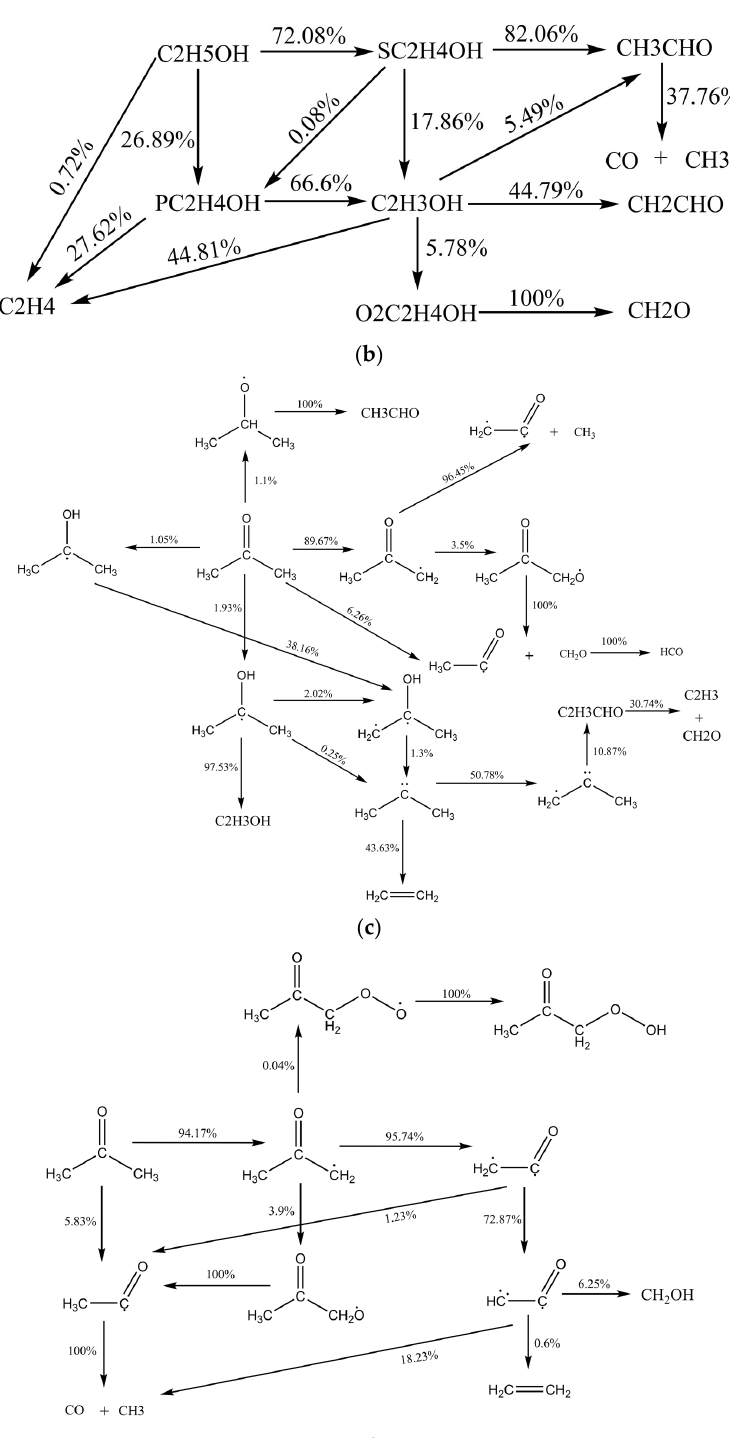
Figure 10. The main reaction paths of ethanol and acetone of ETAC11 at the equivalence ratio of 1.0 (( a ) ethanol, detailed mechanism, ( b ) ethanol, skeletal mechanism, ( c ) acetone, detailed mechanism, ( d ) acetone, skeletal mechanism).